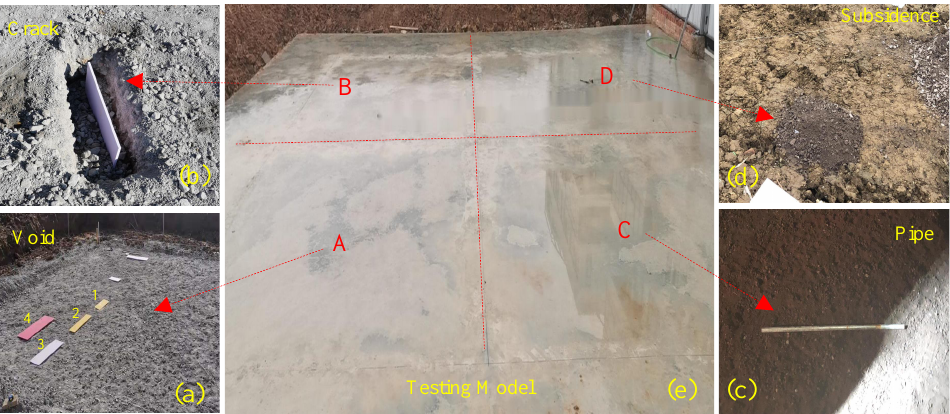
Figure 12. Schematic of testing model and defects: ( a ) Four plastic plates of different thicknesses laid flat simulating the voids; ( b ) A plastic plate was placed at an angle to simulate cracks; ( c ) A steel pipe located at depth of 0.5 m; ( d ) A small round pit filled with structural material of the upper layer simulating the subsidence; ( e ) Testing model.